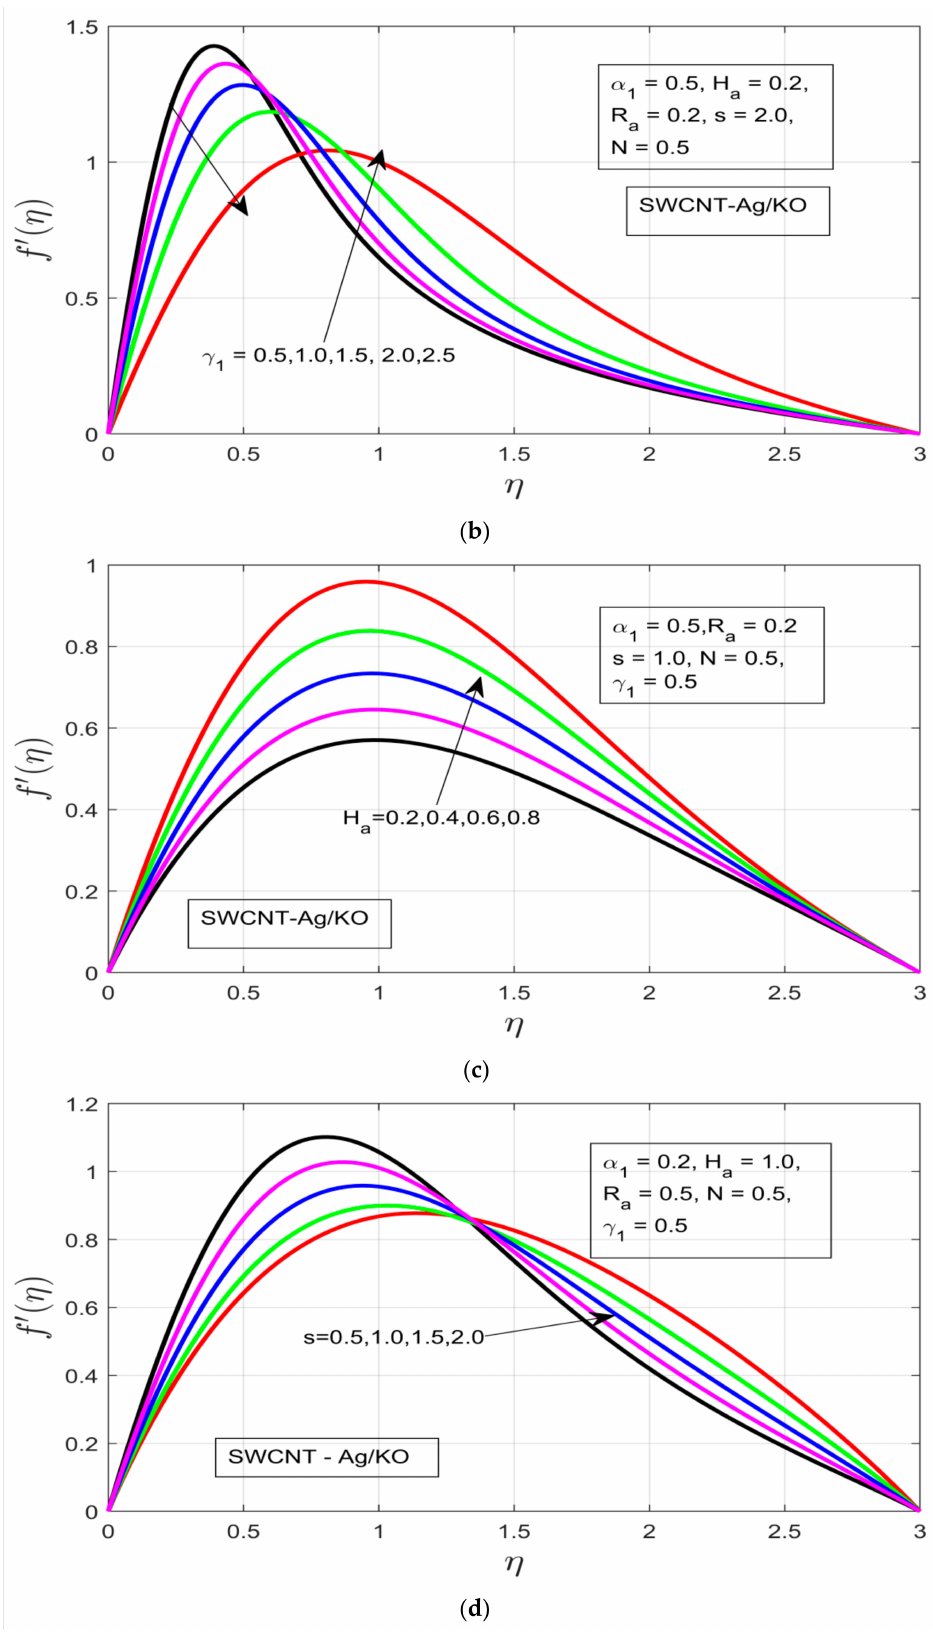
Figure 2. ( a ) Impact of the rotational ratio α 1 on f (cid:48) ( η ). ( b ) Impact of the buoyancy parameter γ 1 on f (cid:48) ( η ) . ( c ) Impact of the Hartman number H a on f (cid:48) ( η ). ( d ) Impact of the unsteadiness parameter s on f (cid:48) ( η )